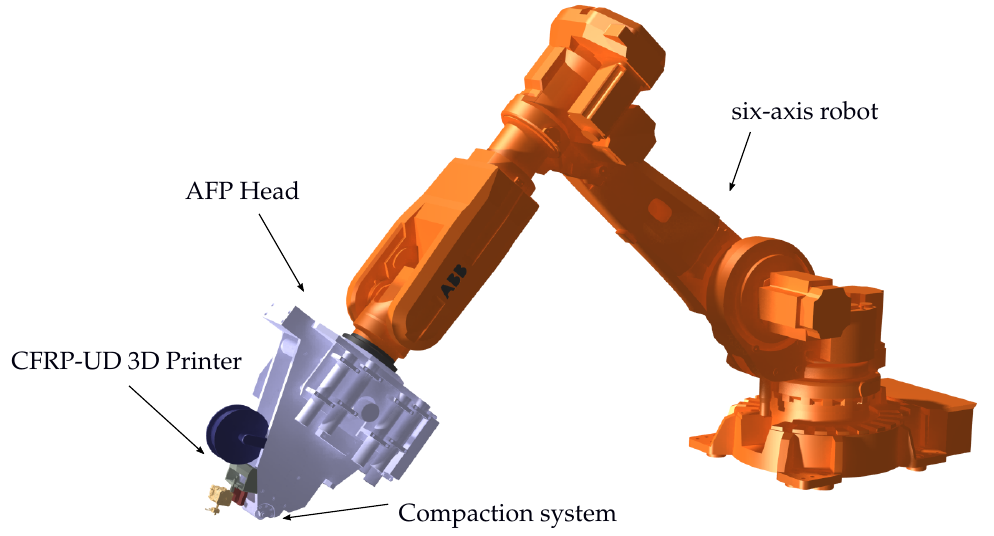
Figure 10. Simplified 3D model of the six-axis robot with an automated fiber placement (AFP) head and integrated 3D printer capable of filling the gaps with continuous carbon fiber thermoplastic